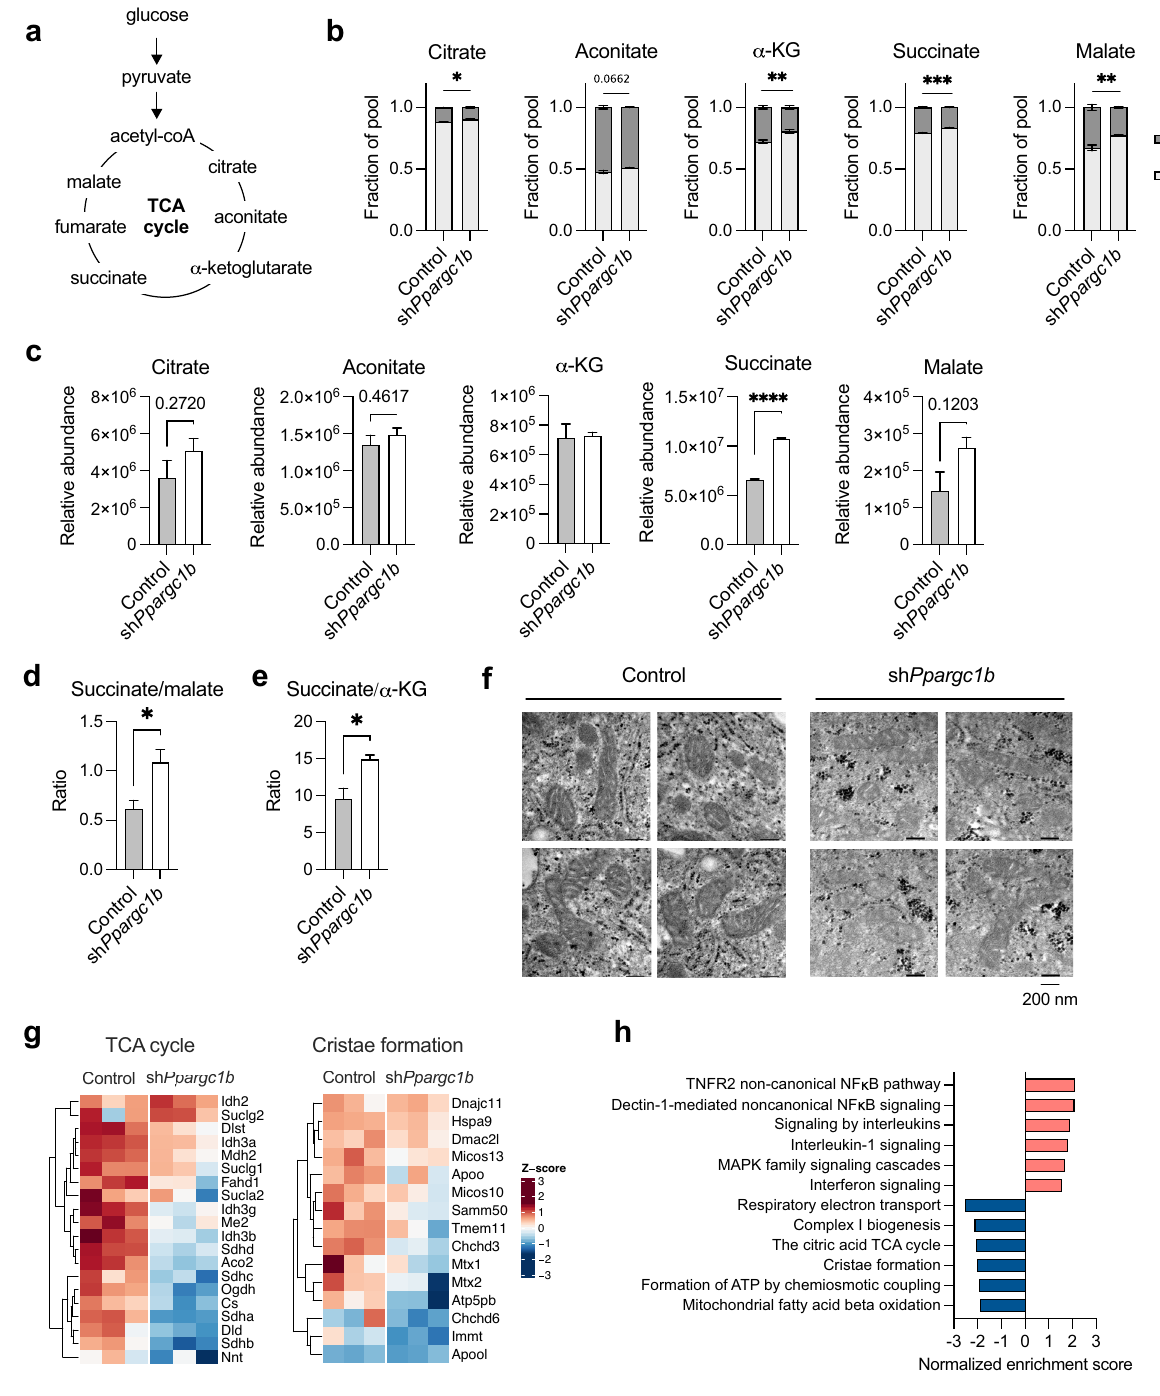
Figure 5. Succinate accumulates in PGC-1β-deficient DCs. ( a ) Schematic of glucose metabolism and TCA cycle. DCs were transduced with control shRNA or Ppargc1b shRNA and ( b ) fractional enrichment of select glucose-derived TCA cycle metabolites was measured following culture with U-[ 13 C]-glucose for 6 h. ( c ) Relative abundance of metabolites were measured by LC–MS (aconitate, α-KG, and succinate) or GC–MS (citrate and malate). ( d ) Ratio of succinate to malate from measurements in ( c ). ( e ) Ratio of succinate to α-KG from measurements in ( c ). ( f ) Mitochondria imaged by transmission electron microscopy (dark dots are microbeads used for sorting). ( g ) Heat maps of the expression of genes from the TCA cycle (left) and cristae formation (right) Reactome pathways. ( h ) Select inflammatory and metabolic Reactome pathways that are significantly enriched in PGC-1β-deficient versus control DCs. Data from ( b – e ) are of one experiment representative of two experiments (s.e.m. of three replicates). Statistical analysis in ( b ) was determined by 2-way ANOVA and represents the comparison of the 13 C-labeled fraction between each condition. Statistical significance for ( c – e ) was determined by unpaired t- test. *p < 0.05, **p < 0.01, ***p < 0.001, ****p <